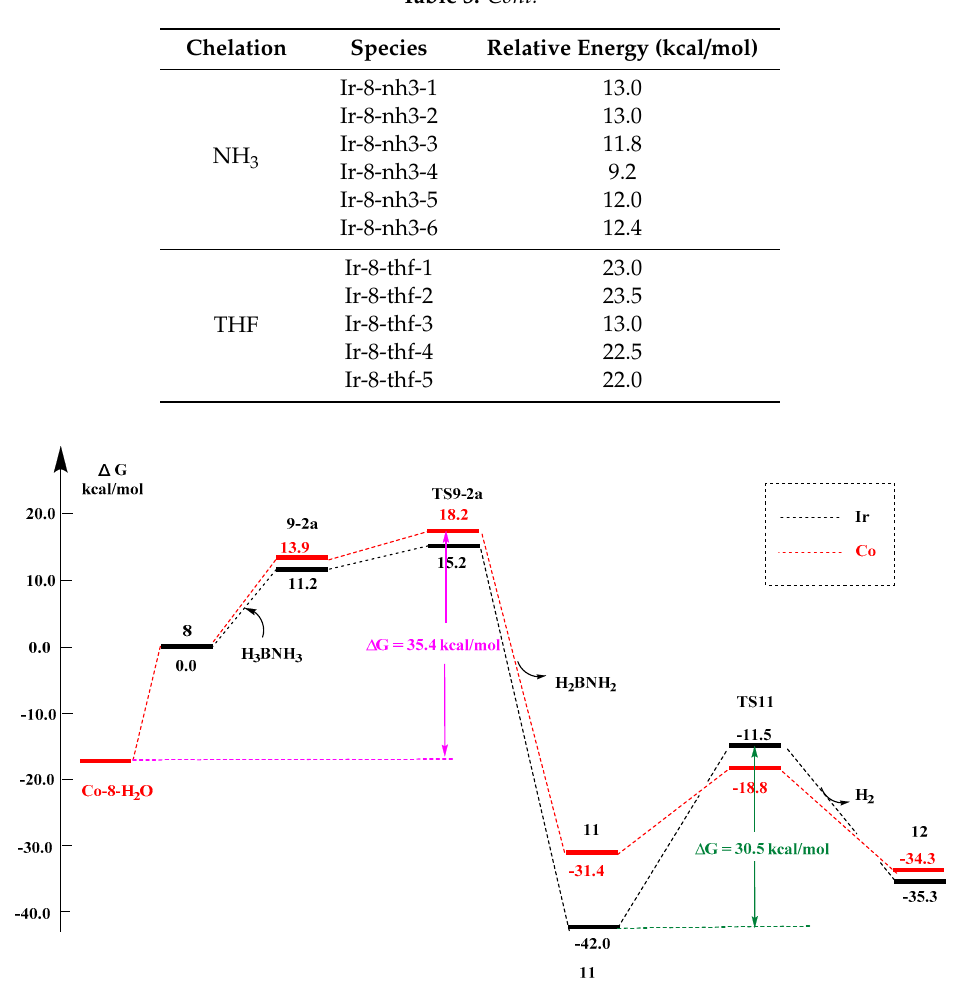
Figure 9. Potential energy profile for reaction between iridium/cobalt PNP complex with ( t Bu) 2 P- substituents and ammonia borane. Table 4. The e ff ect of H 2 O, NH 3 and THF on the stabilization of complex I-8